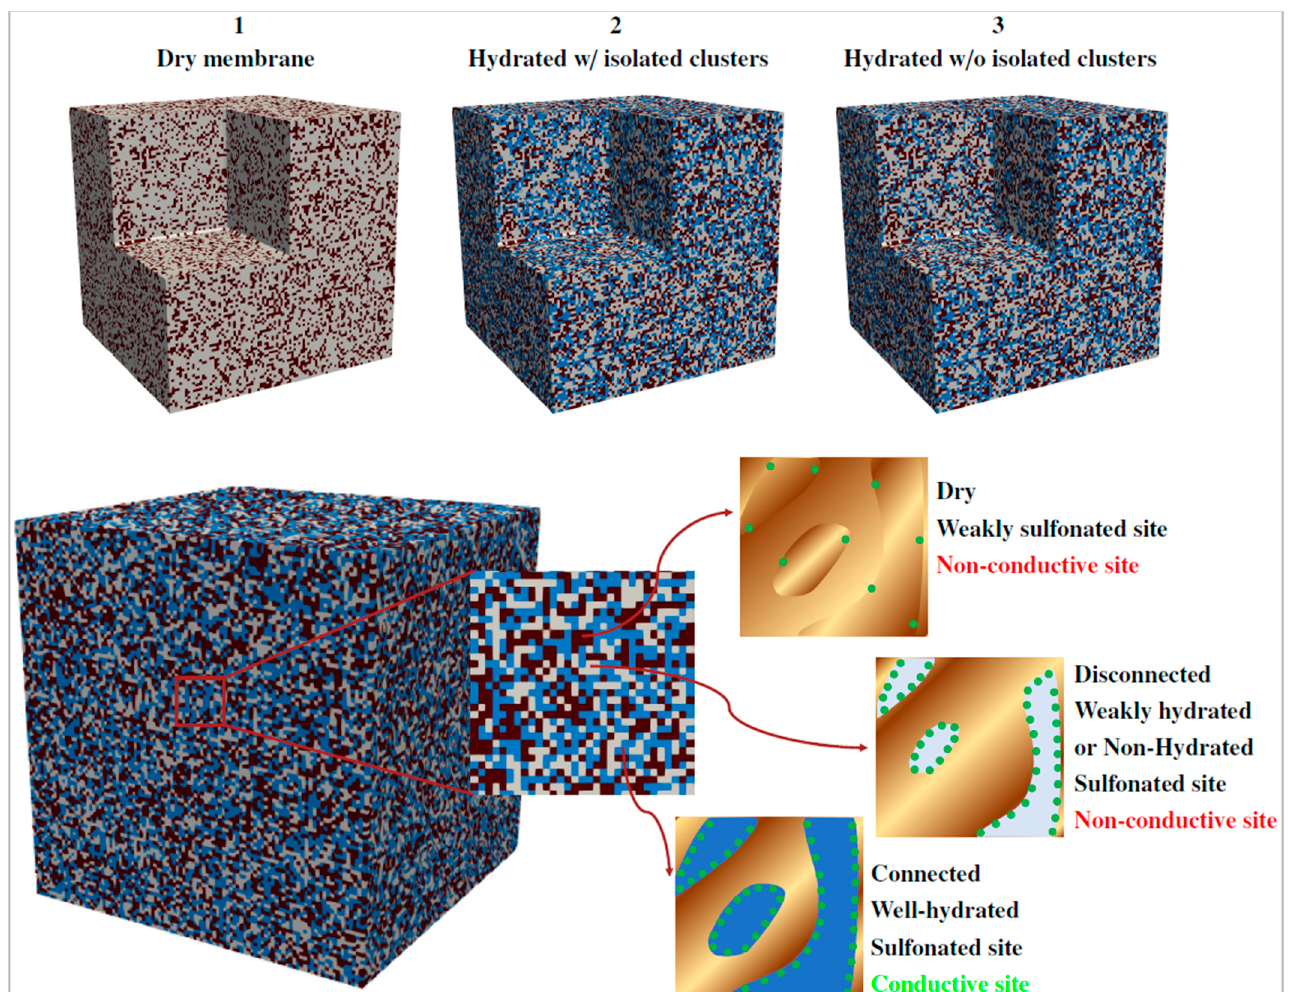
Figure 3. Mesoscopic representation of the copolymer membranes based on a random cubic network composed of well- hydrated sulfonated sites (type 1), weakly hydrated or non-hydrated sulfonated sites (type 2), and dry weakly sulfonated sites (type 3). Each percolation site is internally composed of a random copolymer distribution, either partially filled or not filled of water. Sulfonic groups are represented by green circles. The main steps followed for the generation of the cubic networks are illustrated at the top. Blue sites correspond to type 1, gray sites to type 2, and brown sites to type 3.